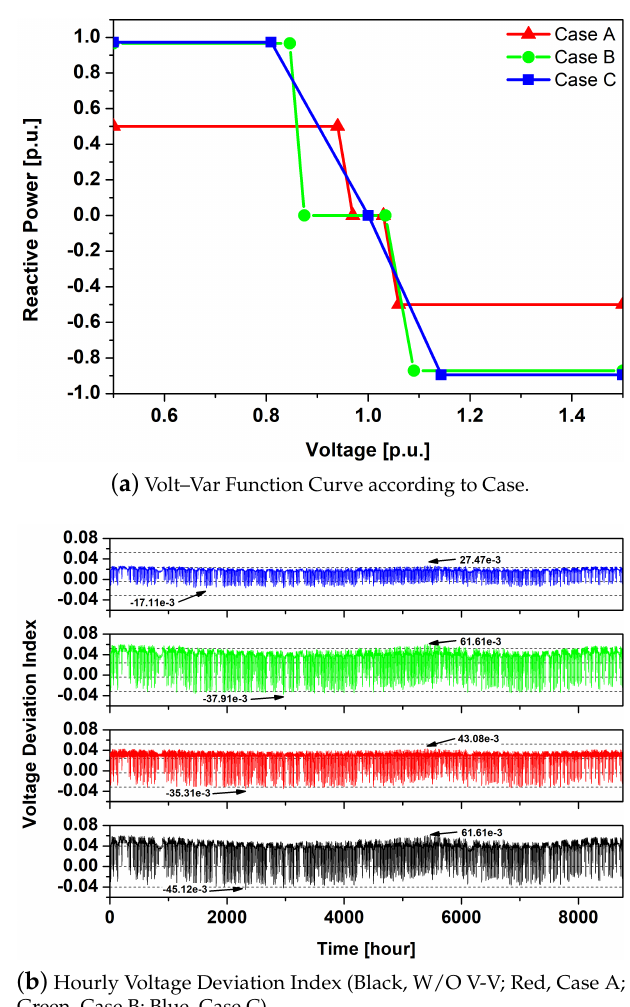
Figure 7. Case Comparison to verify the Improvement Effect on Voltage Deviation